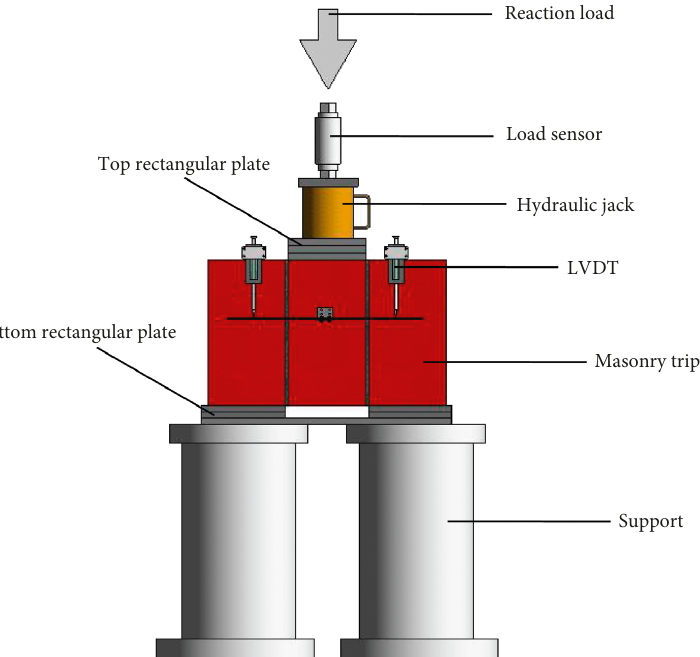
Figure 7: The arrangement of loading device and